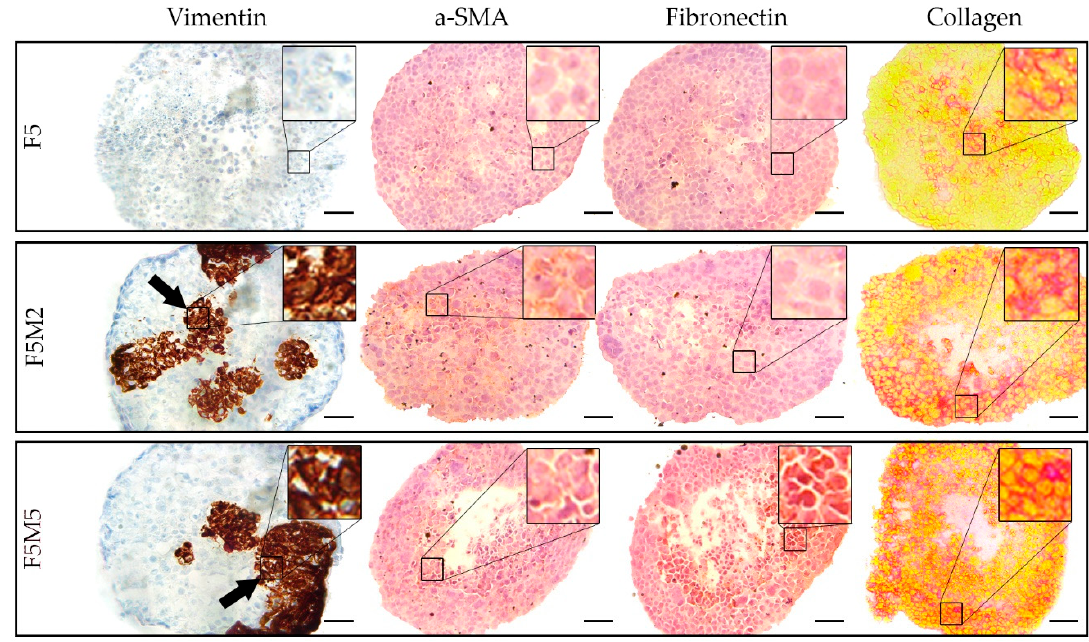
Figure 3. Microscopic images of cryosections of homo- (F5) and heterospheroids (F5M2 and F5M5) at day 5 post-seeding, immunohistologically stained with vimentin, α -SMA, fibronectin and collagen markers. The enlarged (3.5 × ) regions of interest (black squares) are presented in the upper right of each image. Scale bars: 50 µm.